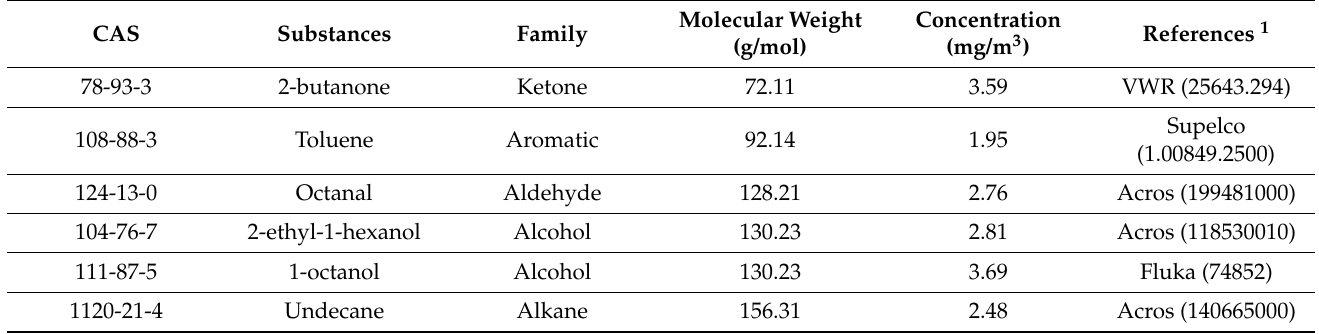
Table 3. Information about substances contained in the solution used for air-controlled